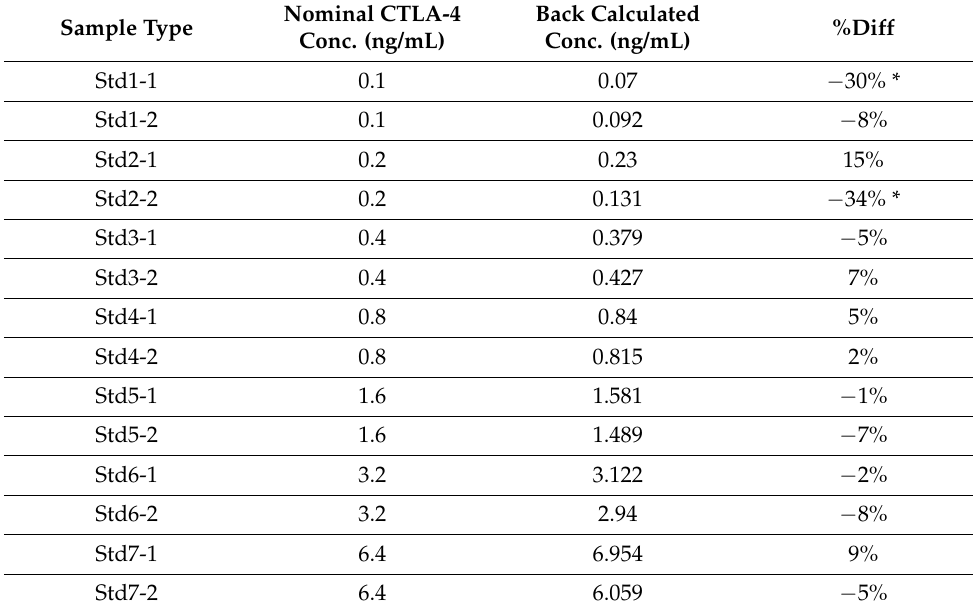
Figure 2. The standard curve and representative LC-MRM MS chromatograms. Table 1. A Representative Standard Curve of Total CTLA-4 Assay.